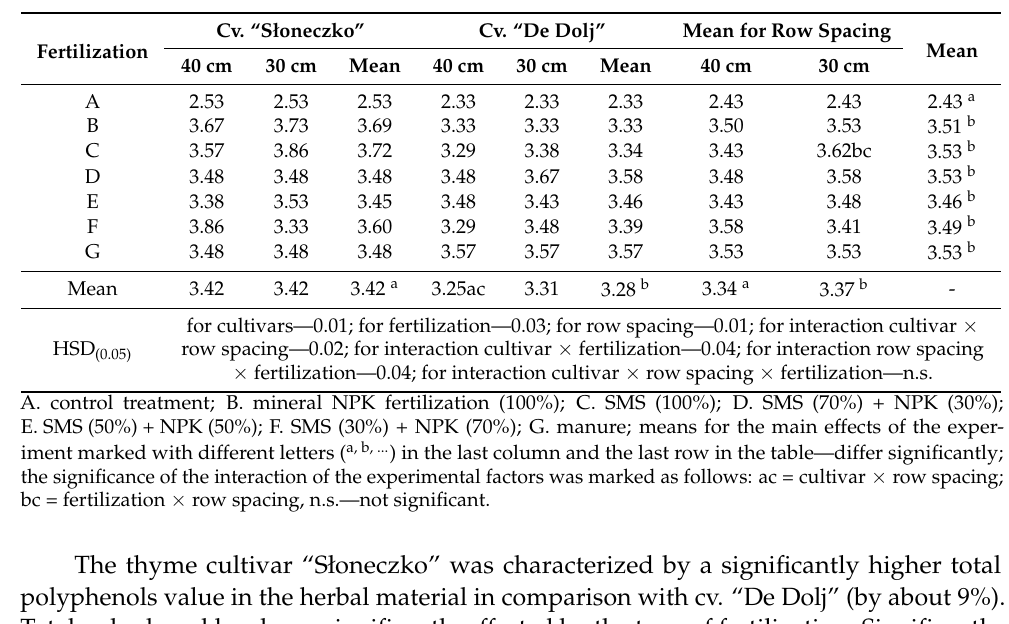
Table 4. Essential oil content in thyme raw material (%DM). Fertilization